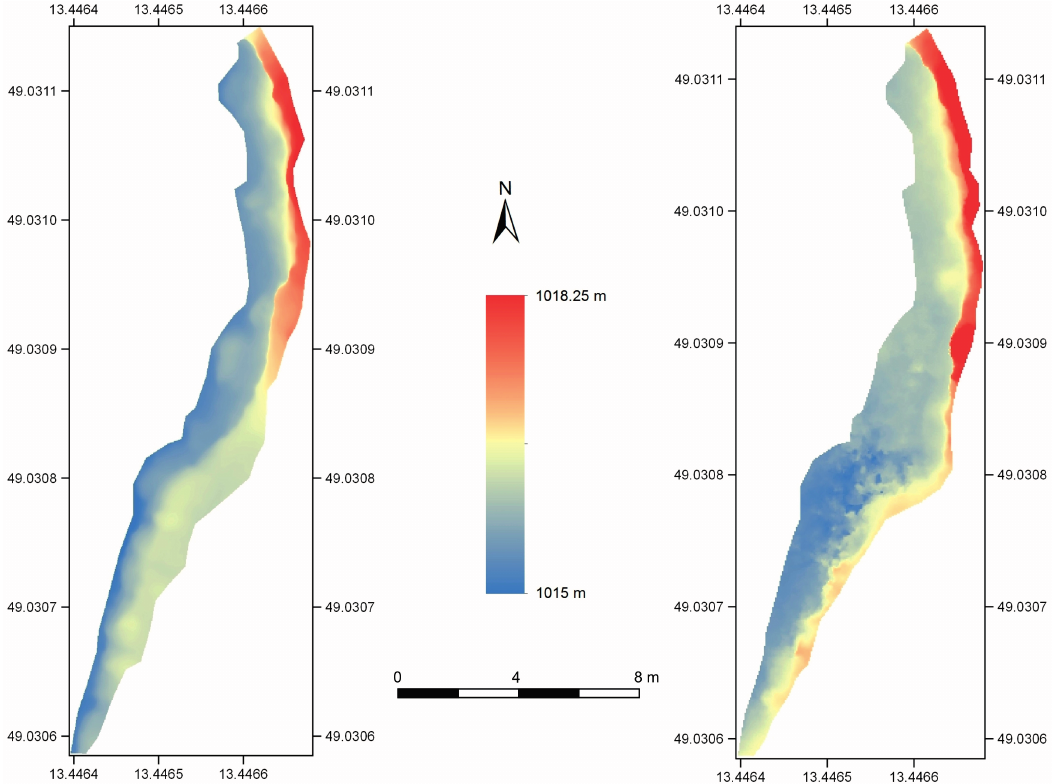
Figure 11. Visualization of 3D model of segment A. Left —May 2013; Right —September 2014.